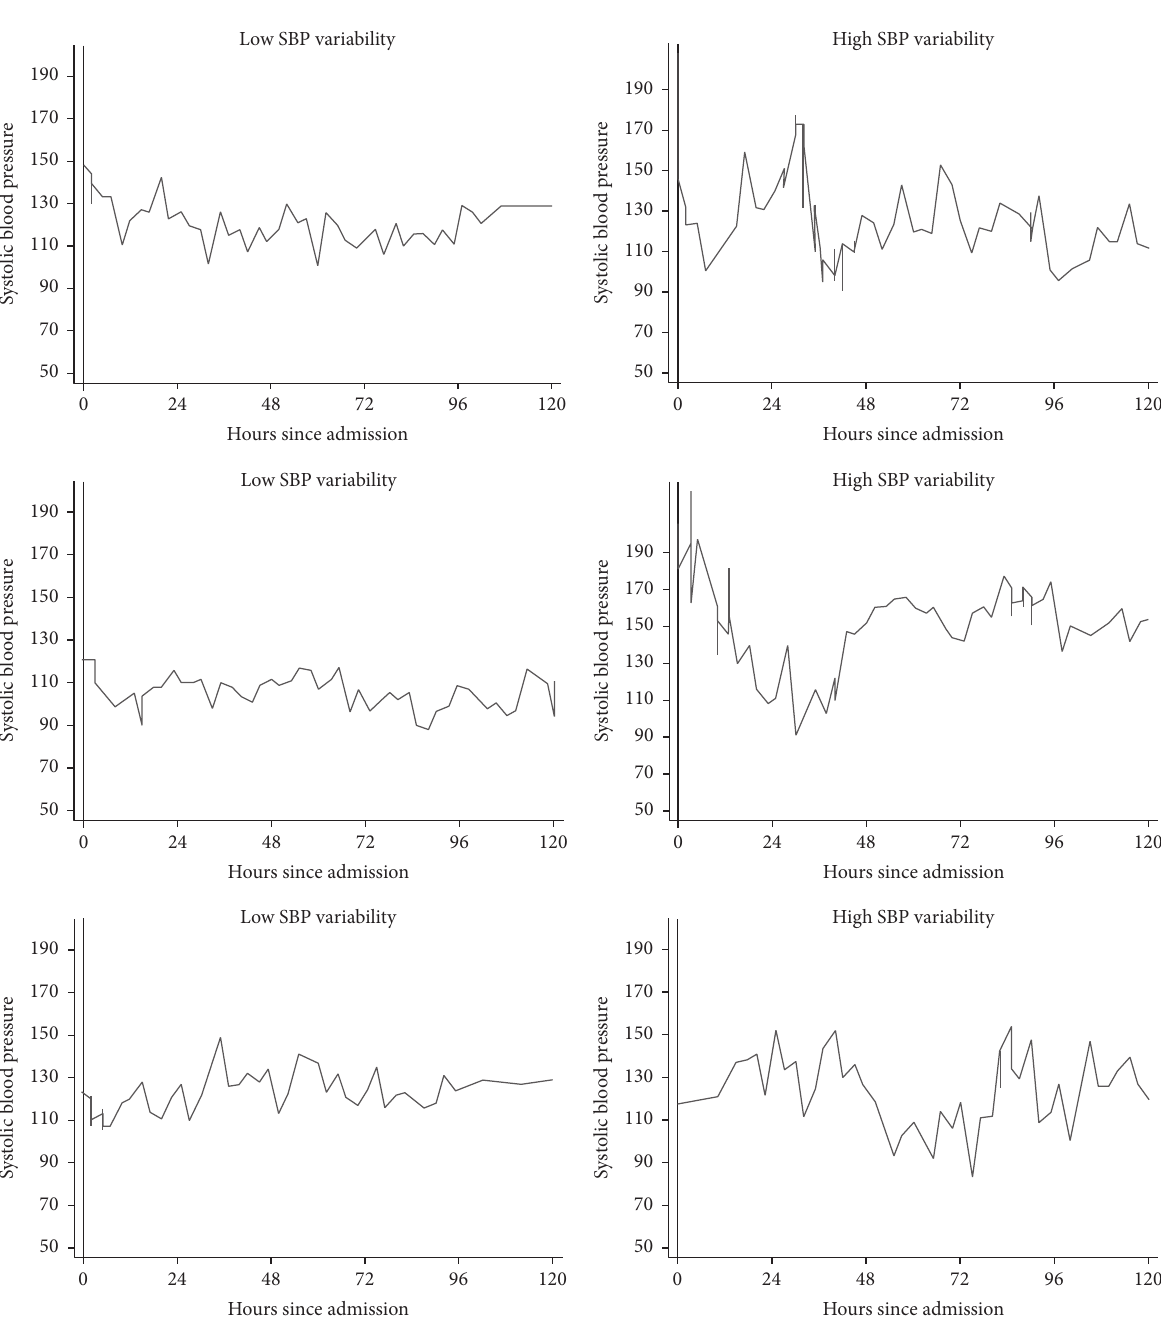
rank correlations between BPV and mRS showed a significant positive association at all time points between mRS and indices of systolic BPV (SD, CV, and SV), but the relationship was inconsistent for diastolic BPV, mean SBP, and